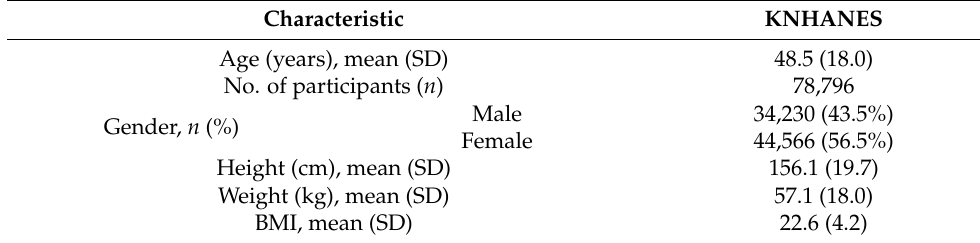
Table 2. Baseline characteristics of the KNHANES